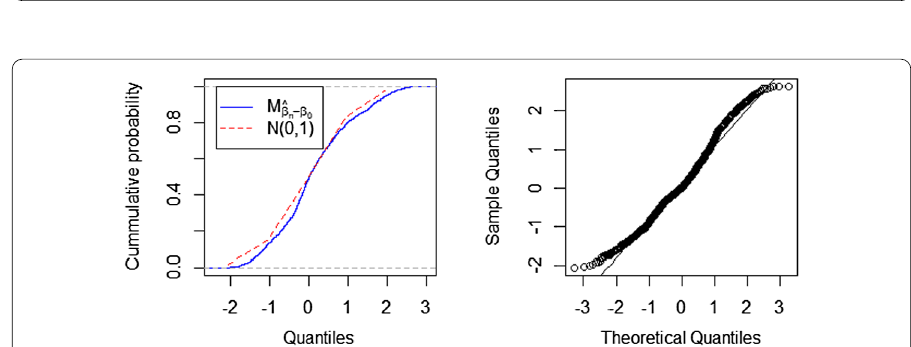
and N (0,1), and QQ-plot of M ˆ β n – β 0